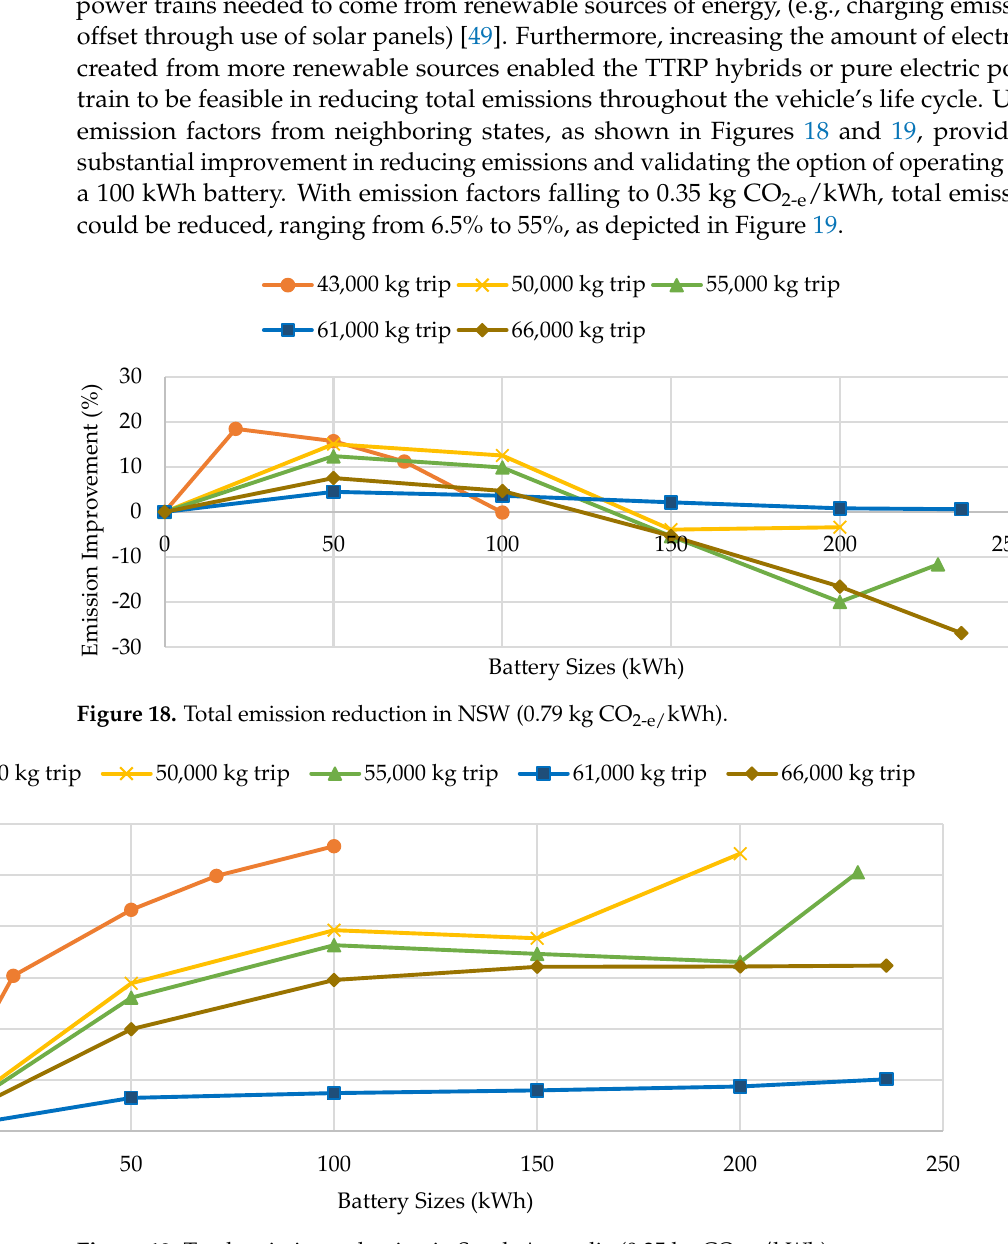
Figure 19. Total emission reduction in South Australia (0.35 kg CO 2-e /kWh).